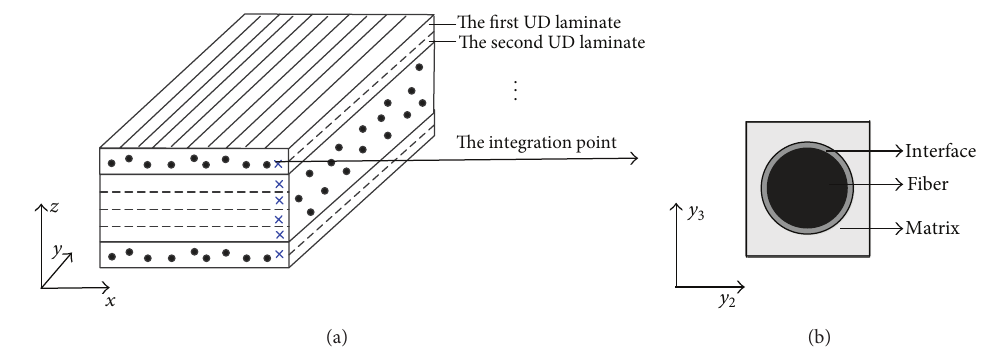
Figure 1: Composite laminate theory analysis with micromechanical model embedded to the proper unit. (a) Composite laminate theory and (b) a proper unit with interface